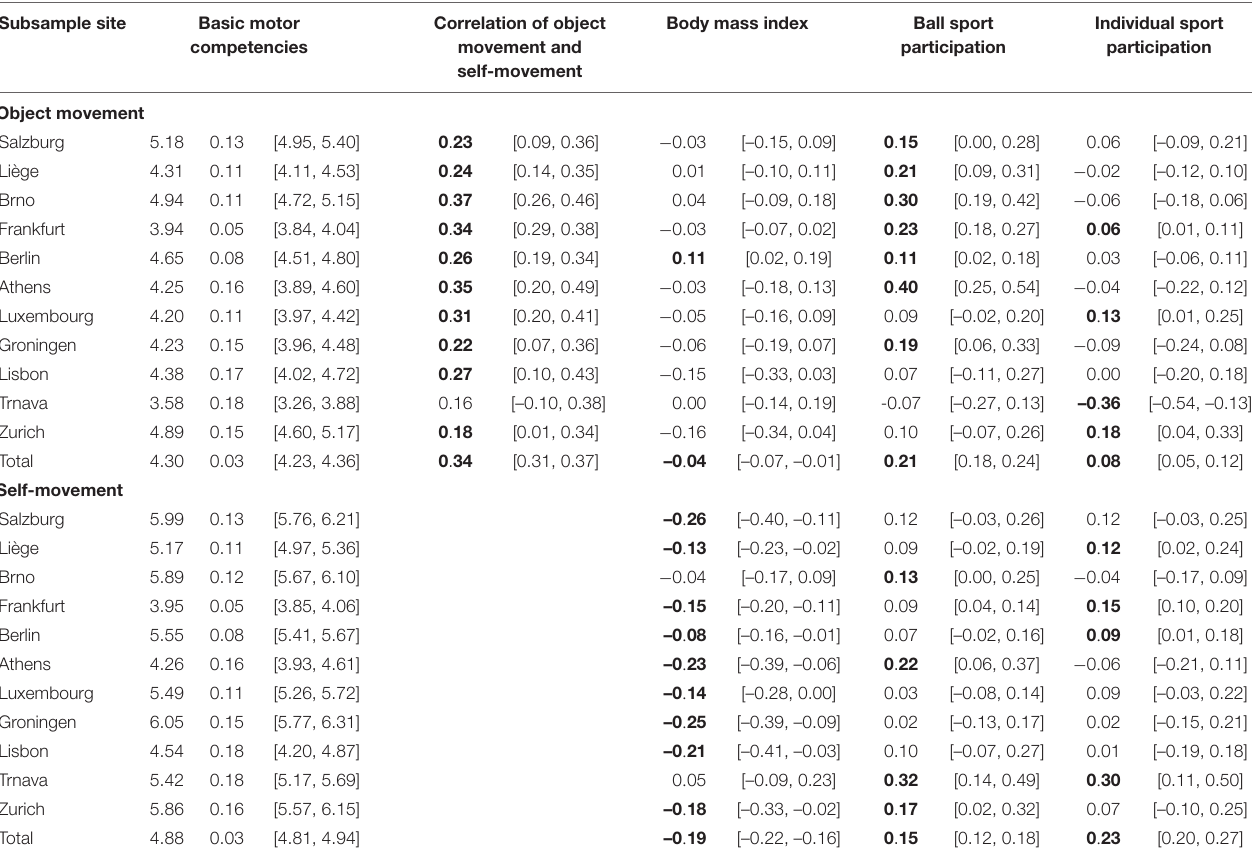
TABLE 4 | Sum values of basic motor competencies (mean, SE , 95% CI ) per competence area, Partial Pearson correlations ( r , 95% CI ) between competence areas per subsample and between motor competence areas and BMI and extracurricular physical activity participation, stratified by sample site. Subsample site Basic motor